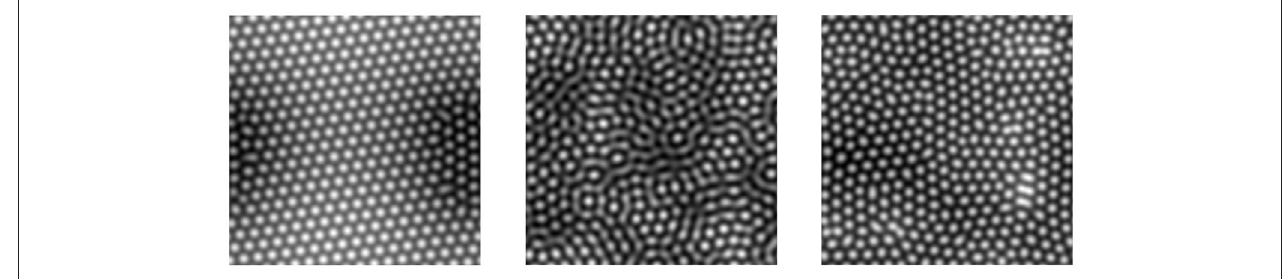
FIGURE 7 | Hexagonal lattices, of varying degree of regularity, created by ion bombardment. Figures from Motta et al.